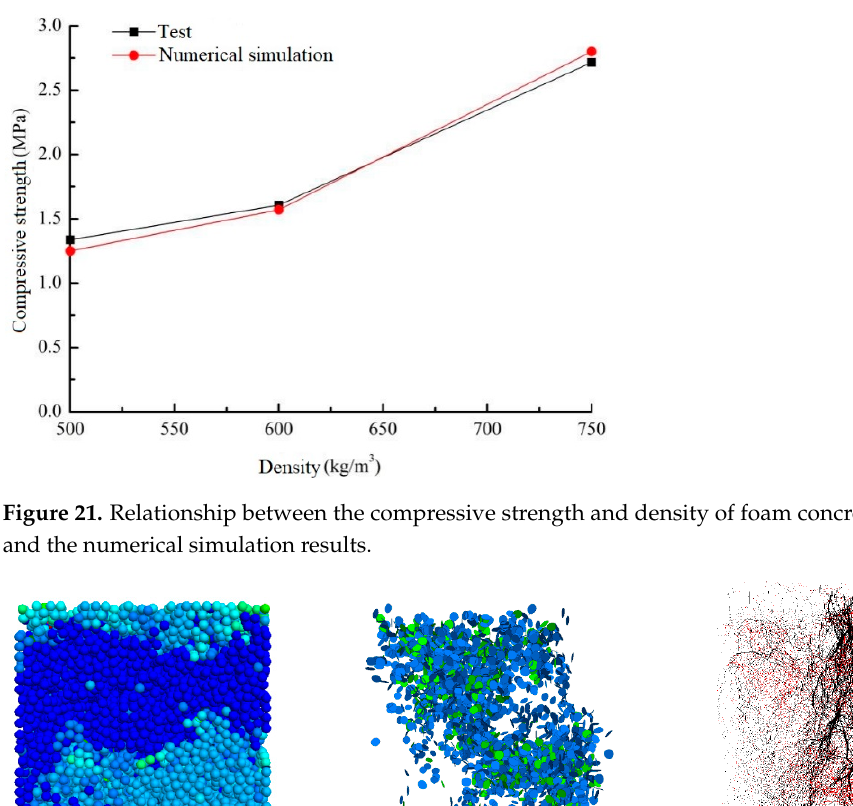
( c ) Figure 23. The failure mode of the foamed concrete with a density of 600 kg/m 3 at a loading rate of 0.06 mm/min. ( a ) model failure mode; ( b ) crack development; ( c ) force-chain distribution. ( a ) ( c ) Figure 24. The failure mode of the foamed concrete with a density of 750 kg/m 3 at a loading rate of 0.06 mm/min. ( a ) model failure mode; ( b ) crack development; ( c ) force-chain distribution. To reveal the reasons for the influence of the loading rate on the failure mode of foam concrete, three loading rates were set for the numerical calculation and kept the density (600 kg/m 3 ) of foam concrete unchanged. In Figure 25, the consistency between experi- mental measurements and simulation is shown; their error is less than 1%, within the ac- ceptable range. The main source of error in numerical simulation and practice was an in- completely consistent pore structure. The crack development inside the model is shown in Figures 26–28. In Figures 26b, 27b, and 28b, the internal cracks of foam concrete gradu- ally increased with the increase in the loading rate, which was consistent with Figure 12. The compressive strength of foam concrete at the two loading rates (0.06 mm/min and 0.6 mm/min) is similar because the loading rate is small. In the case of a low loading rate, the increase in the loading rate will not lead to the obvious development of cracks in foam concrete. However, when the loading rate is high (6 mm/min), the number of internal